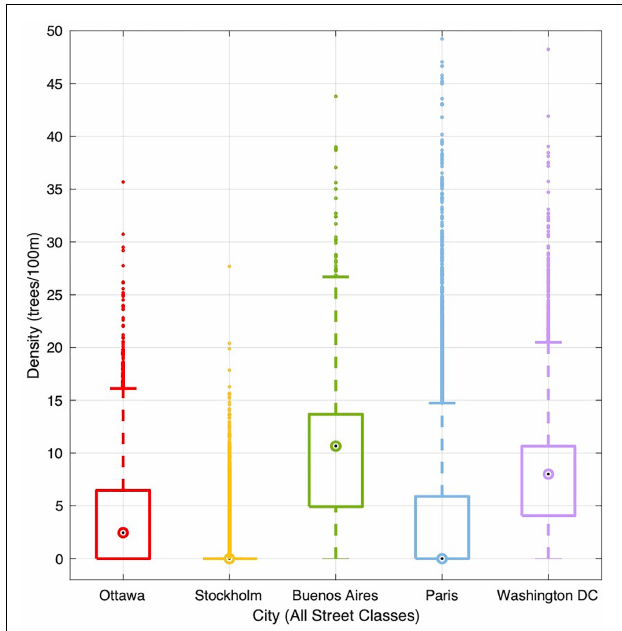
FIGURE 4 | Statistical distribution of street tree density by street